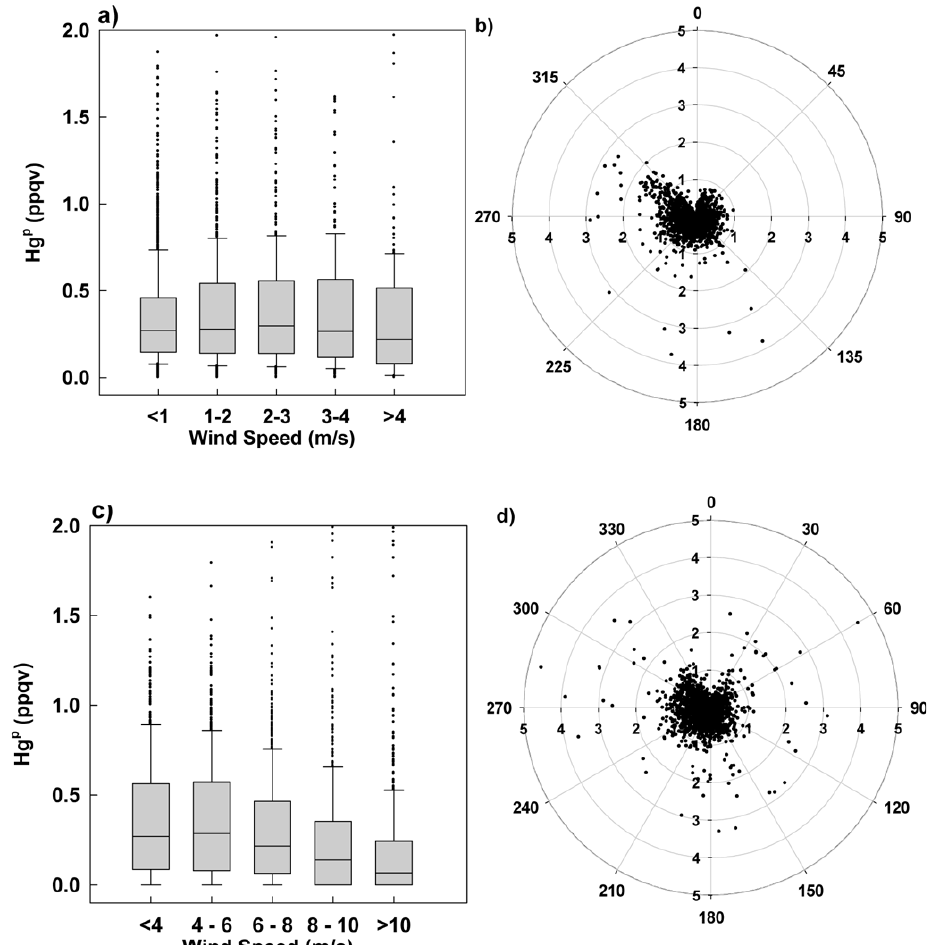
Fig. 5. Hg P mixing ratios versus wind speed and wind direction at TF (coastal) (a, b) and AI (marine) (c, d) .